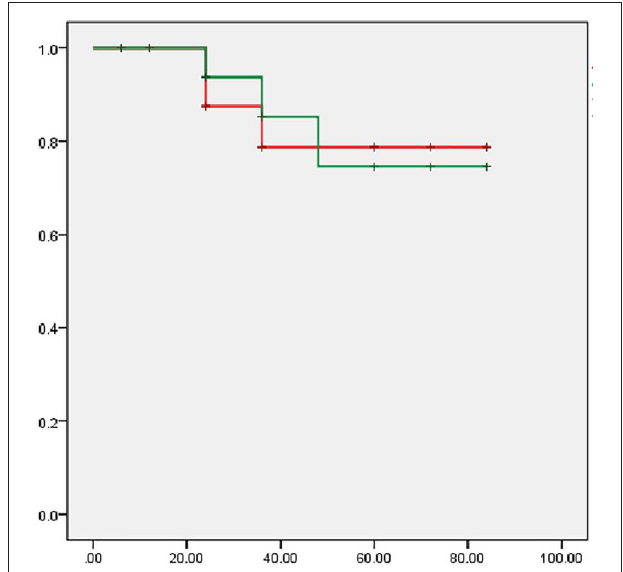
FIGURE 4 | Kaplan–Meier analysis of cumulative primary and secondary patency rates. X-axis: follow-up time (month); Y-axis: patency rates; Red line: cumulative primary patency rate; Green line: cumulative second patency